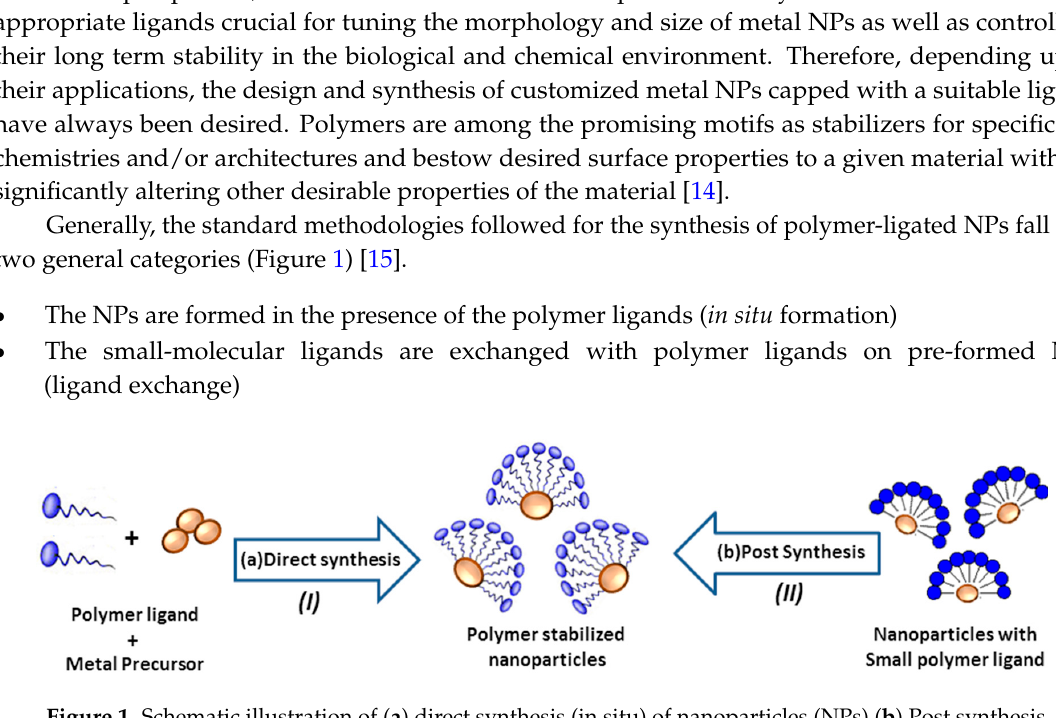
Figure 1. Schematic illustration of ( a ) direct synthesis (in situ) of nanoparticles (NPs) ( b ) Post synthesis capping by ligand exchange method for the polymer stabilized NPs.